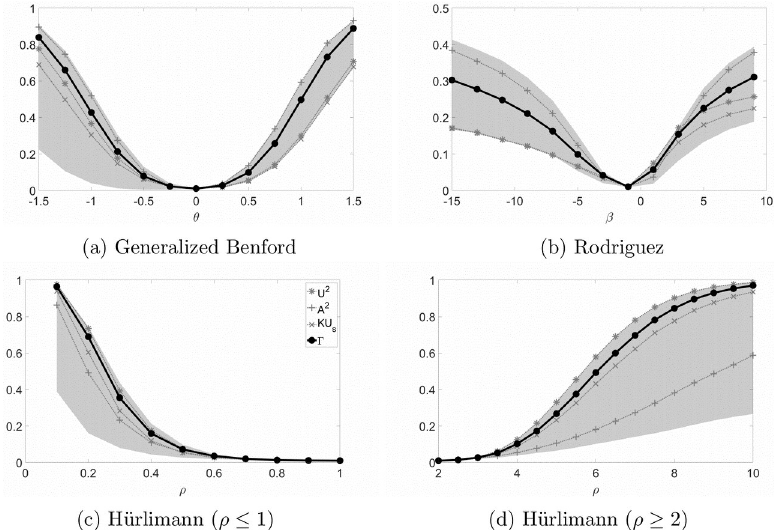
Fig 2. Rejection rates of the combined test for alternative FSD. The gray region represents the area between the maximum and the minimum value of the power obtained in the simulations.